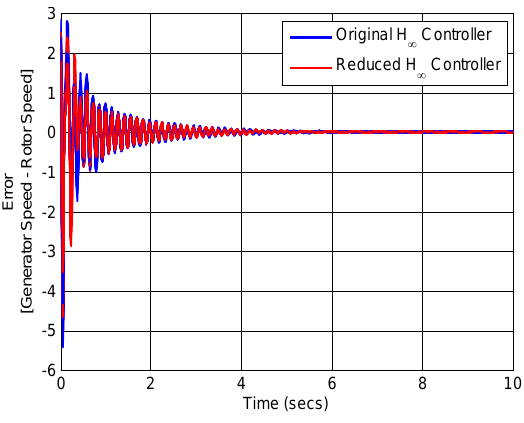
Figure 12. Speed error plot between the generator and rotor – a comparison between original and reduced controllers of wind turbine nominal model with response to reference inputs (pitch angle reference 18 0 and speed reference 42 rpm) and wind disturbance input of 10.0*(rand(1,nstep)) m/s